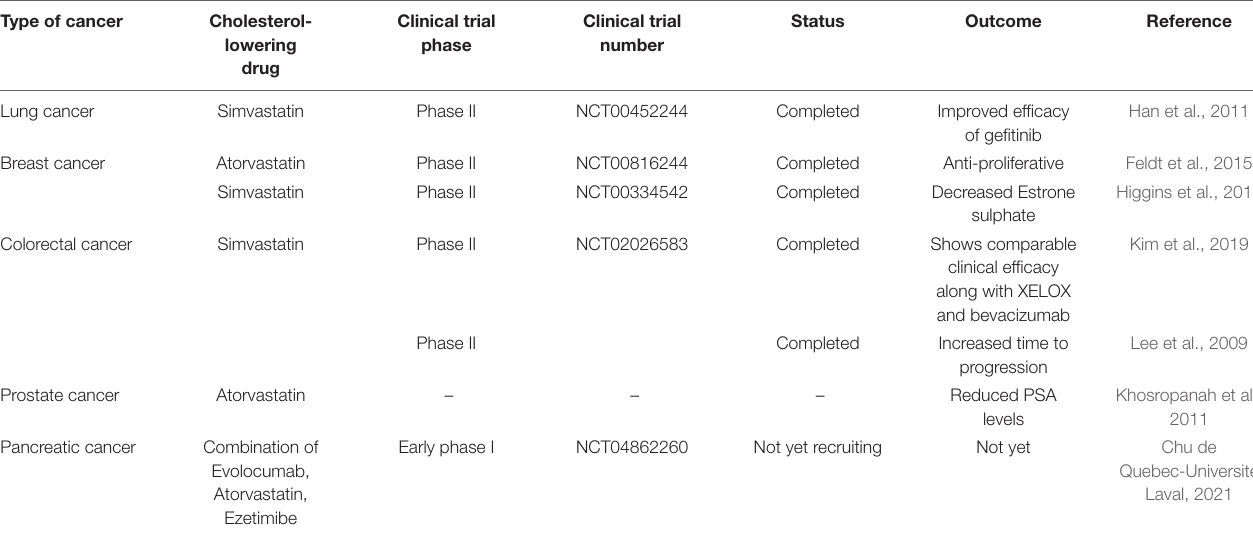
TABLE 1 | Clinical studies and their outcomes in cancer treatment by using cholesterol-lowering